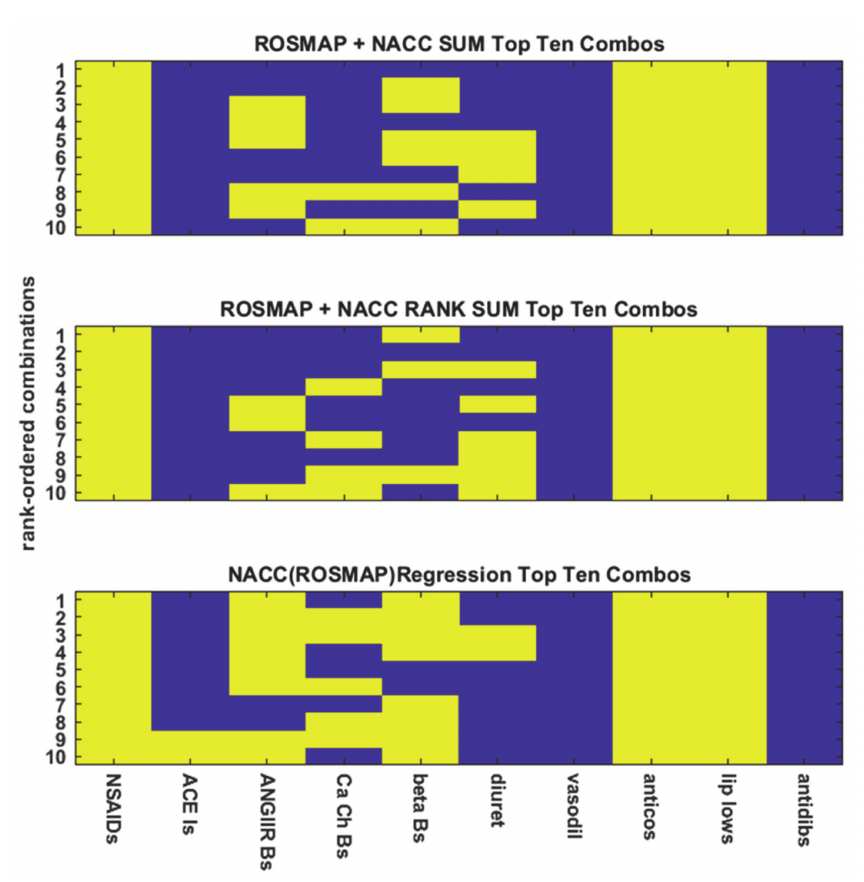
Figure 6. Different joint ranking methods yield similar orderings of drug combinations. The ten best combinations of the ten drug categories that do not include estrogen/progestin or target cognitive ability or mood, as predicted jointly by ANNs trained separately on the ROSMAP or NACC datasets, are rank ordered in three different ways and displayed as heat maps (yellow, drug present; blue, drug absent). Each column represents one of the 10 drug categories (category names are abbreviated). The top ten combinations all include NSAID, antihypertensive, anticoagulant, and lipid-lowering drugs, whether the ranking is based on the sum of separately predicted potencies (ROSMAP + NACC SUM), the sum of the ranks of separately predicted potencies (ROSMAP + NACC RANK SUM), or the projections onto the regression line giving NACC potency as a function of ROSMAP potency (NACC(ROSMAP)). Concerning the third method, note that the NACC(ROSMAP) and ROSMAP(NACC) (ROSMAP potency as a function of NACC potency) regressions yield identical orderings of drug-combination predicted potency (Supplementary Figure